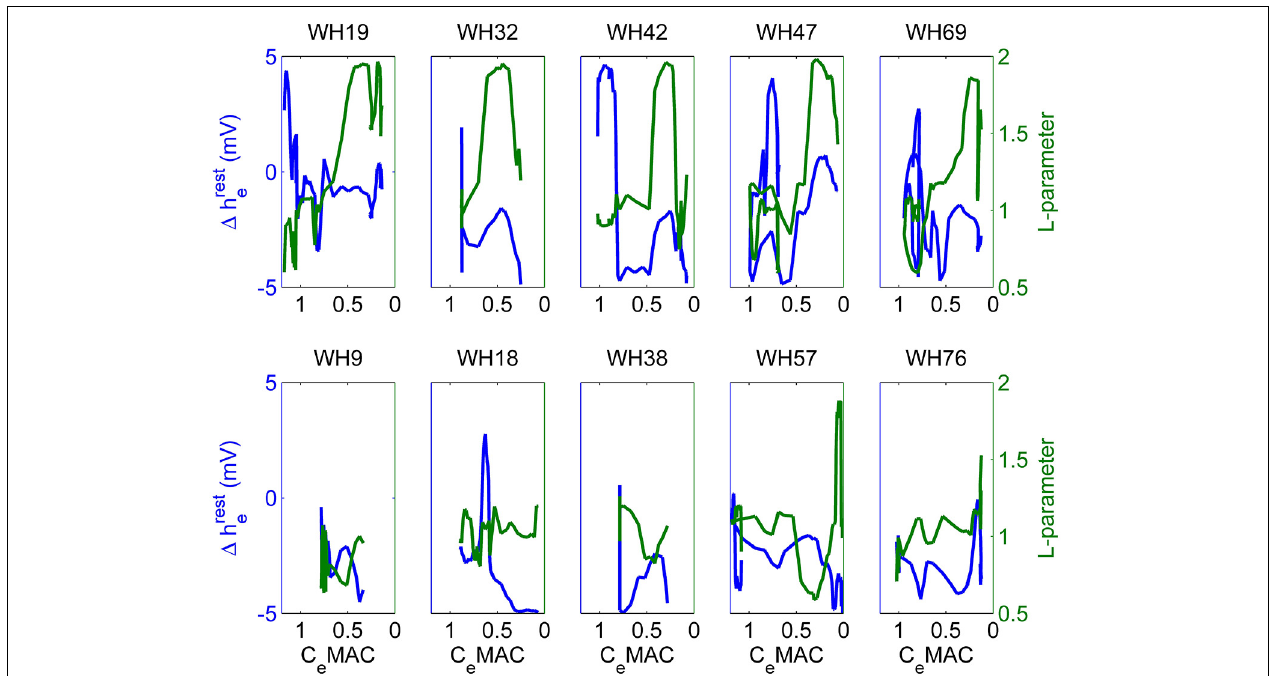
FIGURE 12 | Change in resting membrane impedance ( (cid:2) h rest e , blue line, left axis), and excitatory connection strength (L-parameter, green line, right axis) plotted against decreasing anesthetic concentrations